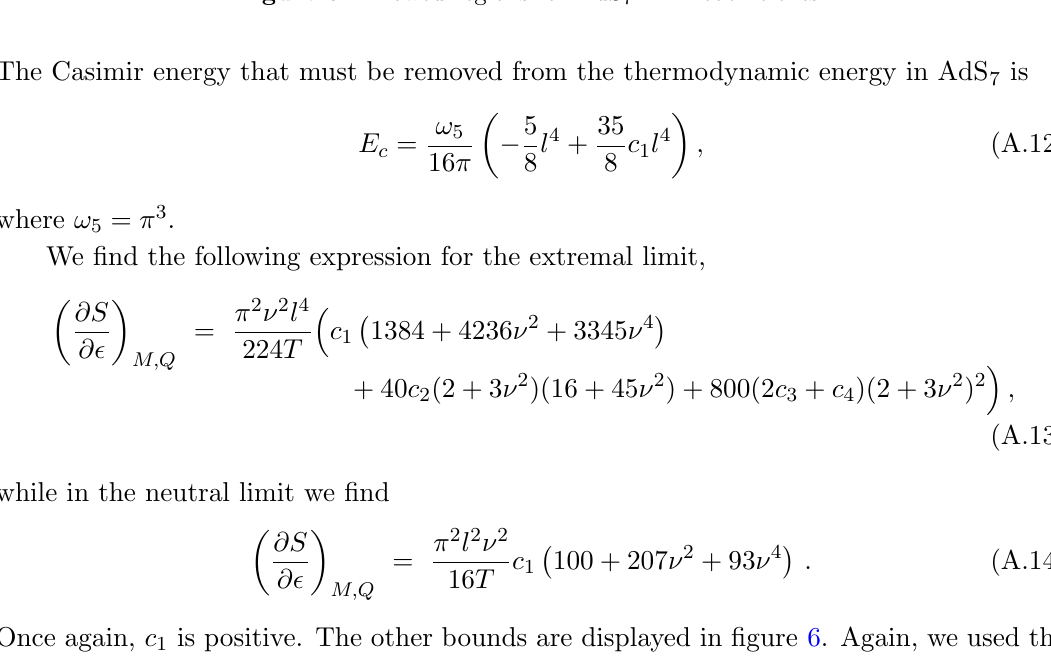
Figure 6 . Allowed regions for AdS 7 EFT